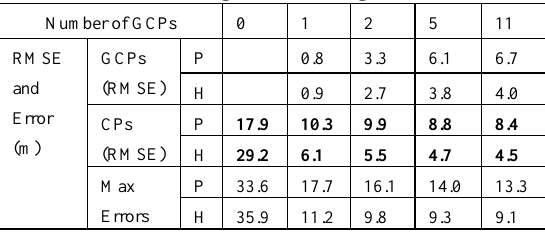
Figure 6 sketch map for attitude measured value and compensation value